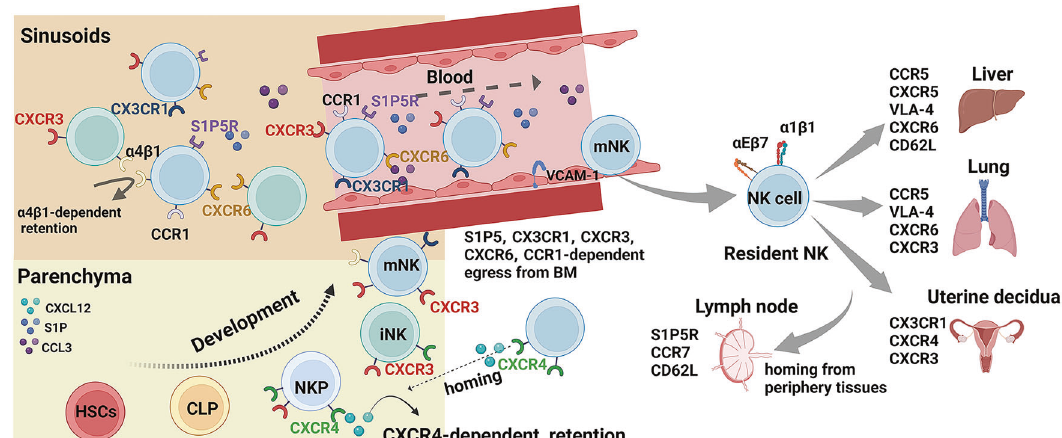
Fig. 3 NK cell traf fi cking and homing at steady state. NK cells develop from HSCs in the BM parenchyma and gradually reach blood and peripheral tissues as they mature. CXCR4 is highly expressed in immature NK cells, including NKPs and iNKs, making NK cell remains in or homes back to the BM parenchyma. When CXCR4 expression is downregulated and the expression of CXCR3, CXCR6, S1P5 and CX3CR1 is upregulated, NK cells gradually egress from the BM and enter peripheral tissues via circulating blood. Created with